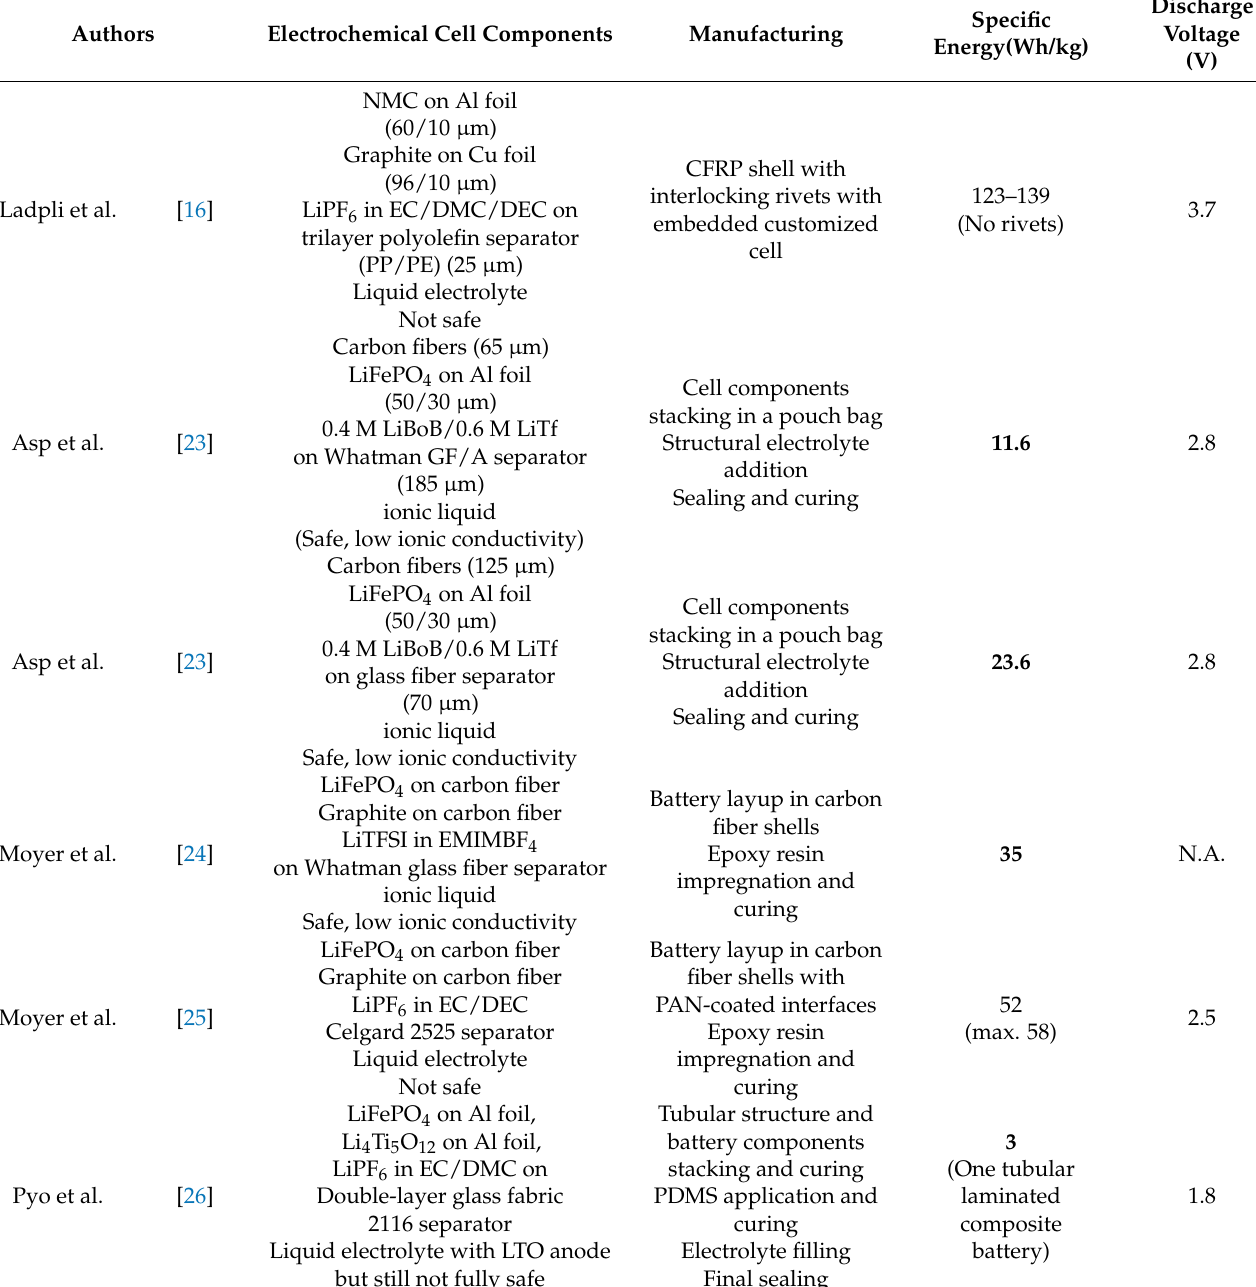
Table 1. All-solid-state structural battery